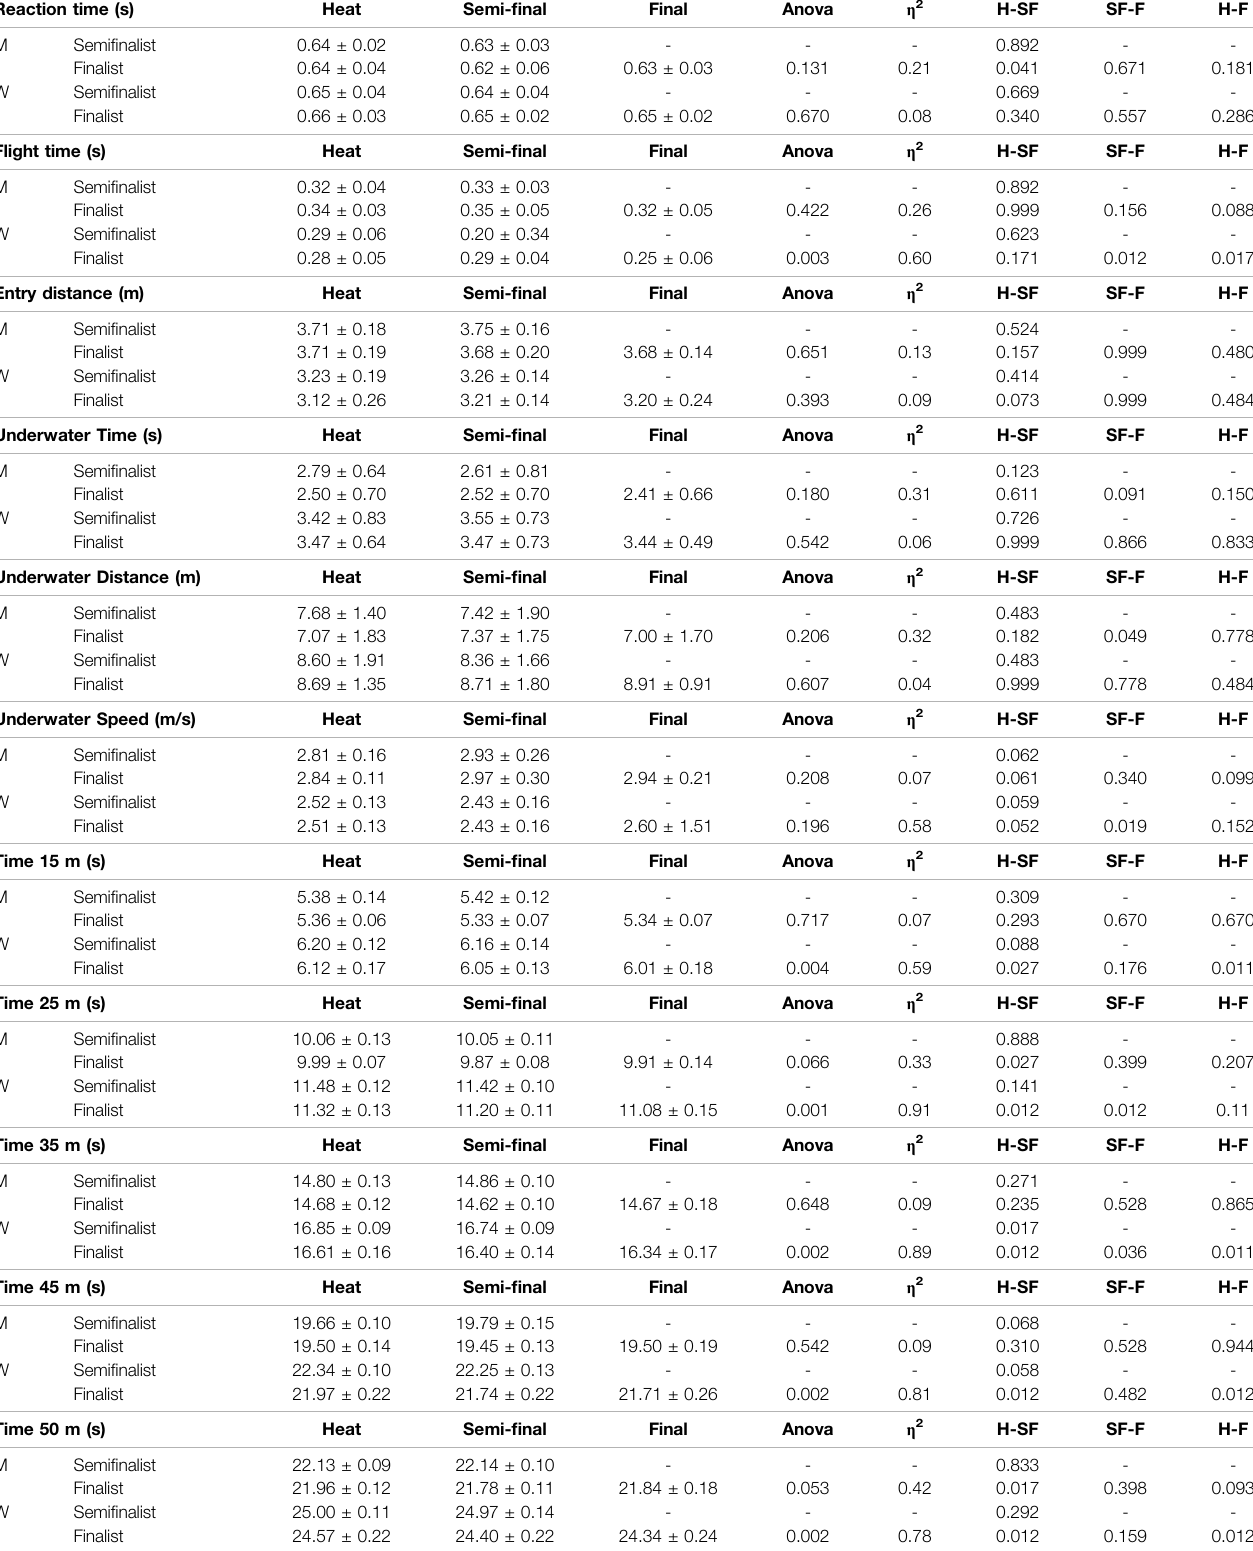
TABLE 1 | Freestyle performance variables ’ results, p values, and effect sizes ( η 2 ) between the different three rounds. Men (M); Women (W) (LEN European Senior Championships 2021). Reaction time